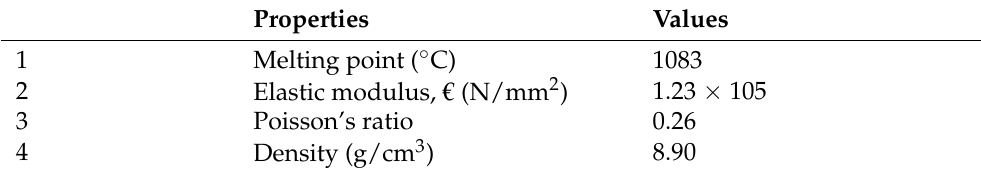
Table 5. Properties of the electrode material.